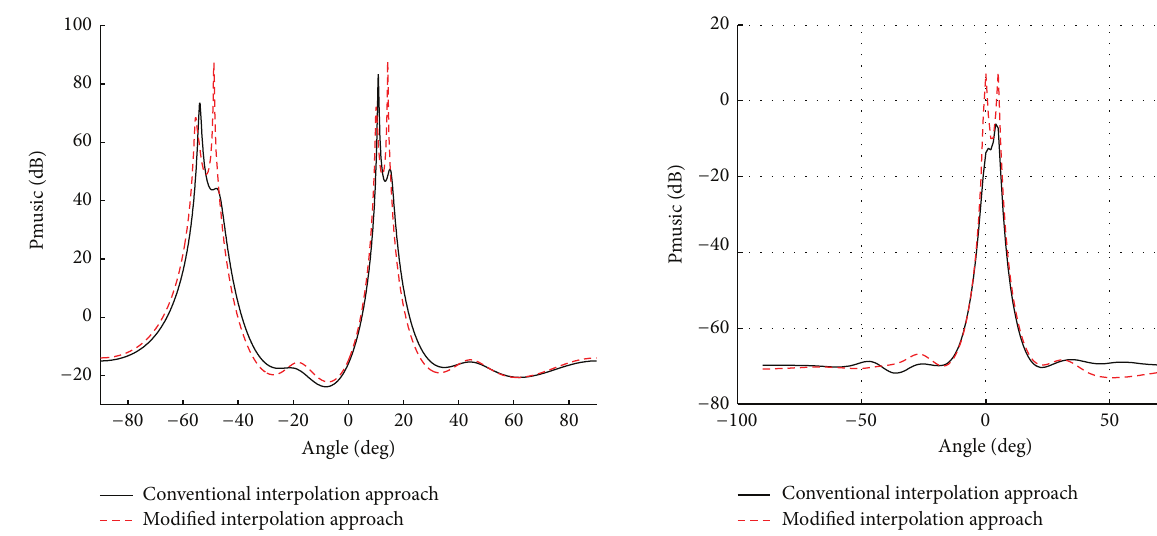
Figure 4: Spatial spectrum of MUSIC algorithm for two methods comparison.